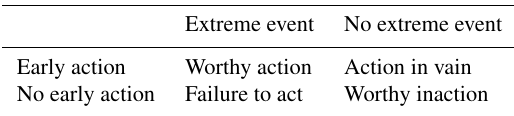
Table 1. Contingency table demonstrating potential outcomes of forecast-based